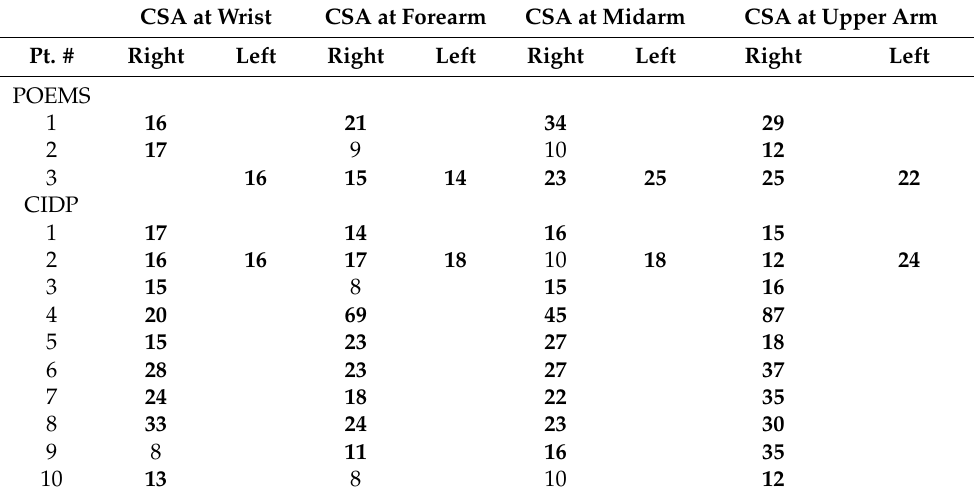
Table 4. HRUS findings in upper limb nerves: median nerve CSA values in mm 2 . CSA at Wrist CSA at Forearm CSA at Midarm Pt. #